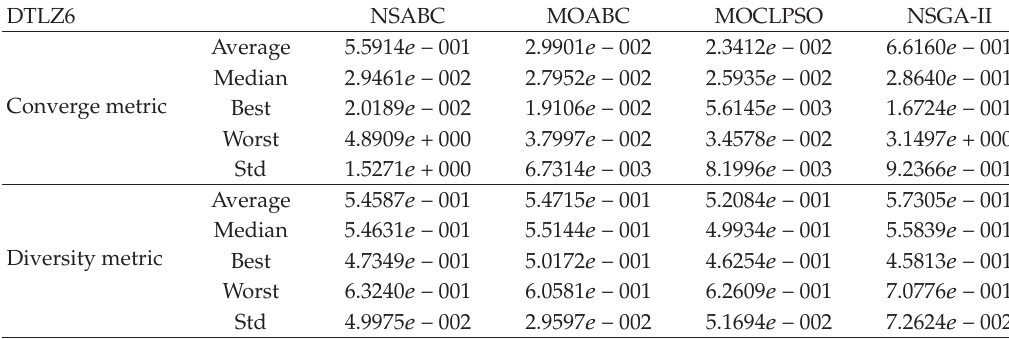
Table 21: Comparison of performance on DTLZ6 after 10000 FEs. DTLZ6